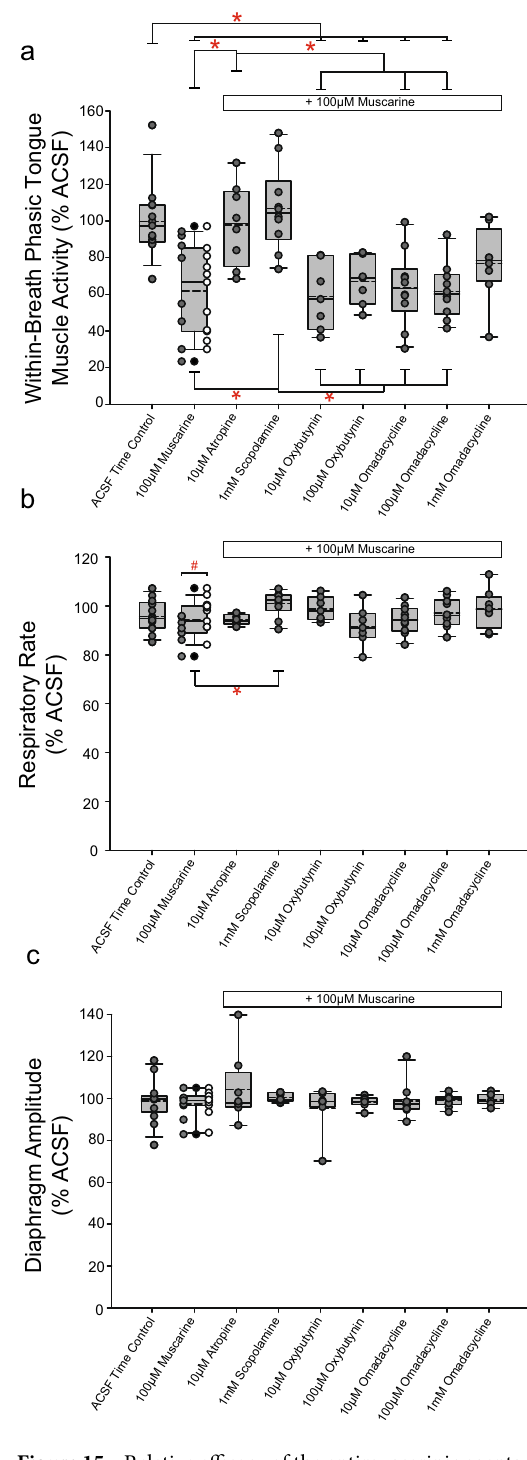
Figure 15. Relative efficacy of the antimuscarinic agents at the HMN in Study 3 in reducing muscarine-induced tongue motor suppression and ACSF time controls. Individual and group data showing respiratory motor responses across protocols. Data are normalized to the baseline ACSF control period in each individual. Box and whisker plots show individual and group data comprising the plot (median [dashed line], mean [solid line] and 25th and 75th percentiles) for within-breath phasic tongue muscle activity ( a ), respiratory rate ( b ), and diaphragm amplitude ( c ). Male and female responses for the protocols with muscarine only are indicated by gray and white circles respectively. *, indicates p <